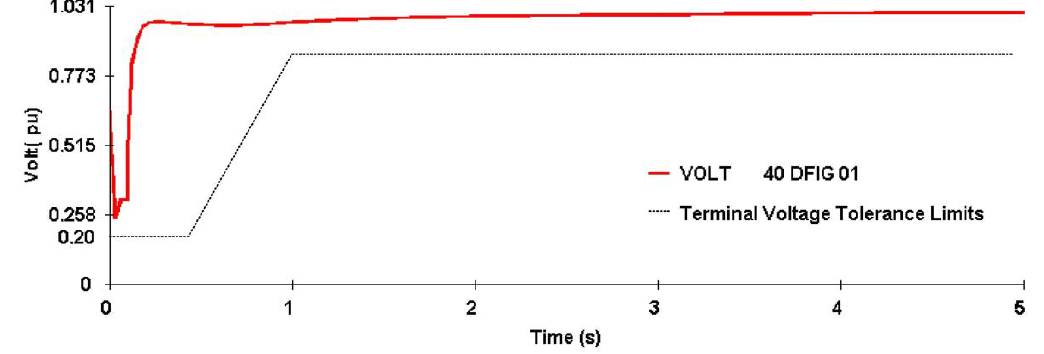
Figure 17. Terminal voltage of the DFIG in bus 40 after the short circuit with the DT rules and optimization of FLUPOT.